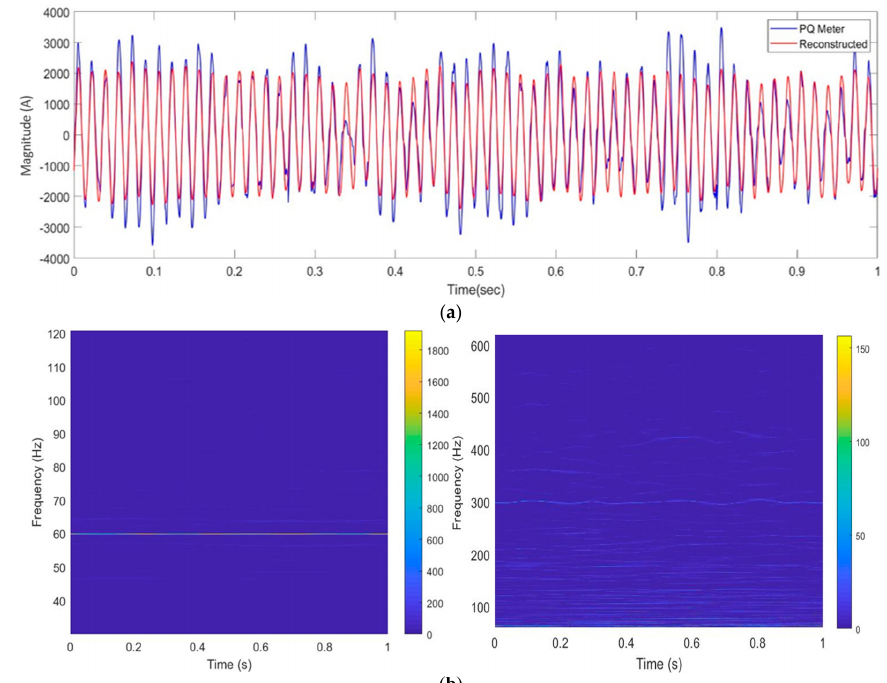
Figure 10. EAF case: ( a ) the actual measured current waveform and reconstructed one using the proposed method, ( b ) time–frequency ridges.